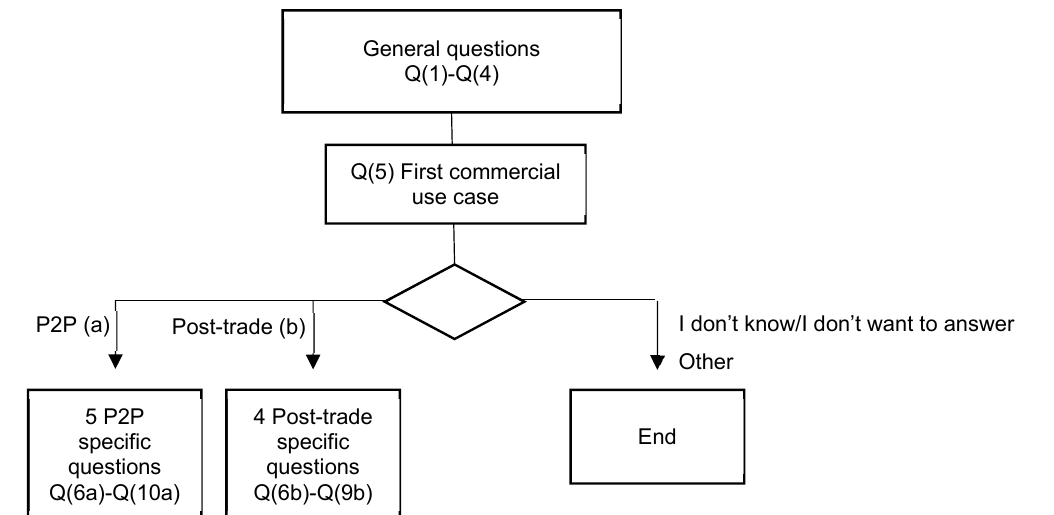
Figure 4. Flow chart to questionnaire.